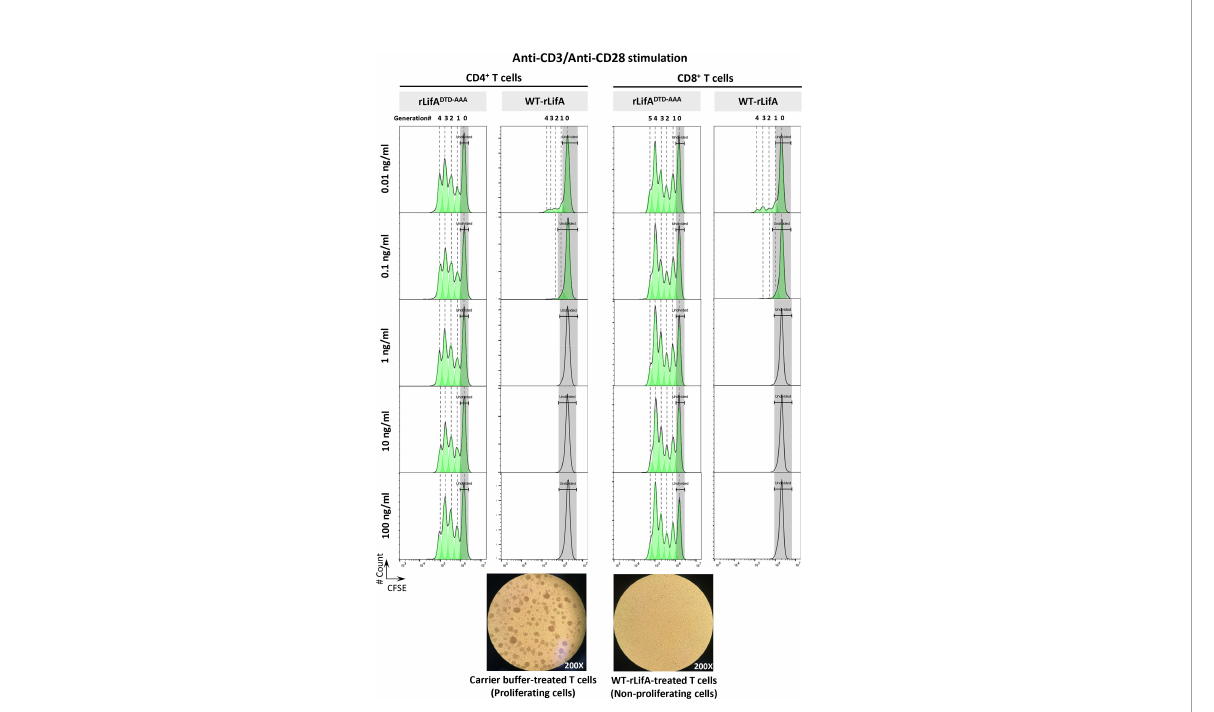
FIGURE 1 Lymphostatin inhibits proliferation of human CD4 + and CD8 + T cells in a manner dependent on its DTD motif. Upper panel shows CFSE content of the anti-CD3/anti-CD28-stimulated CD4 + and CD8 + T cells in the presence of rLifA DTD-AAA and WT-rLifA. The CD4 + and CD8 + T cell populations were determined by gating on CD3 + /CD4 + and CD3 + /CD8 + , respectively. Lower panel shows a representative light micrograph of the anti-CD3/anti-CD28-stimulated T lymphocytes 3 days after treatment with carrier buffer (left) or 10 ng/ml of WT-rLifA (right) (200X magni fi cation). Data are representative of one